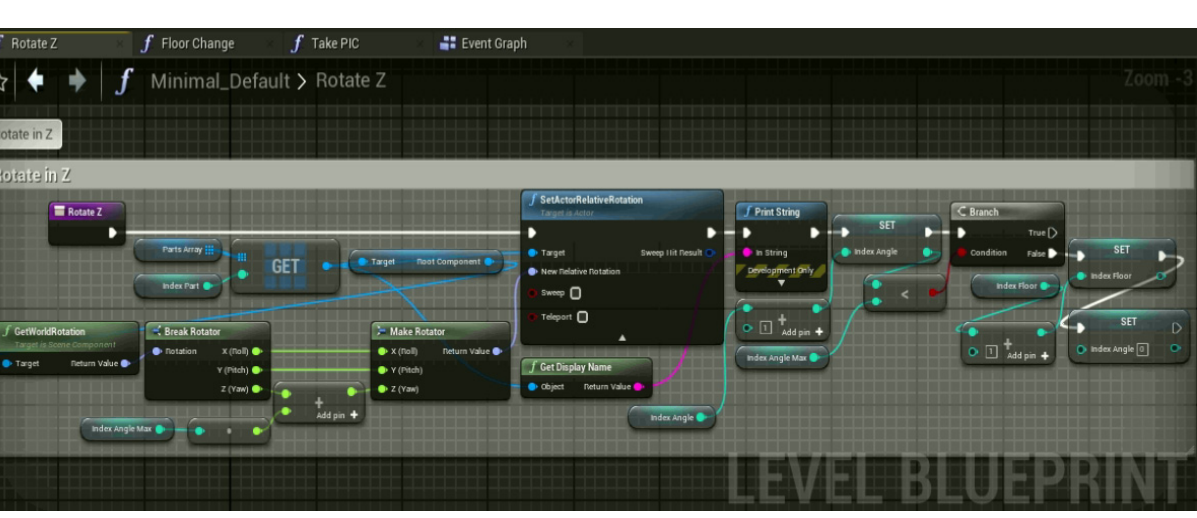
Figure 7. An example of a visual script for automated part rotation in Z-axis using the algorithm coded in the Blueprint Scripting Language.